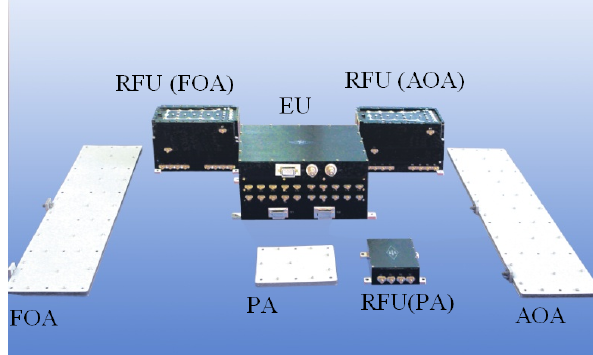
Figure 2. The FY3-C GNSS occultation sounder GNOS. The GNOS instrument consists of one electronic unit (EU), two fixed occultation antennas (one forward occultation antenna, FOA, and one aft occultation antenna, AOA), one position antenna (PA), and three radio frequency units